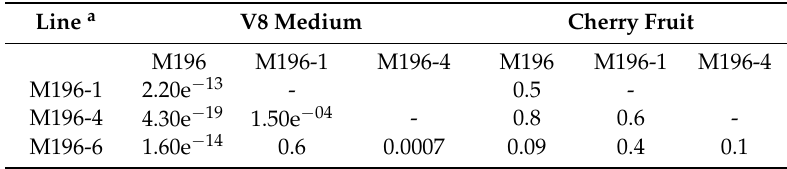
Table 3. p -values of paired comparisons between M. fructicola isogenic lines of colony diameter on V8 medium and lesion diameter on cherry fruits.